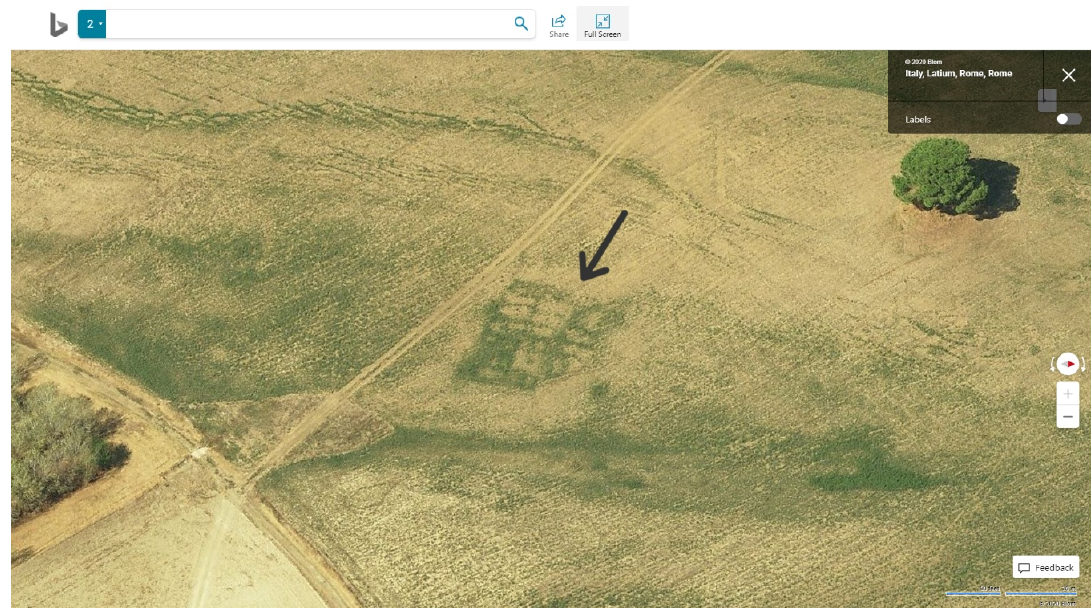
Figure 9. An example of an archaeological cropmark with two positive detections (see black arrow). This is in proximity to the Via Nomentana. It appears to be a cropmark of a Roman villa, but more data would be needed to verify the nature of the structure. The Microsoft product screenshot is reprinted with permission from Microsoft Corporation.